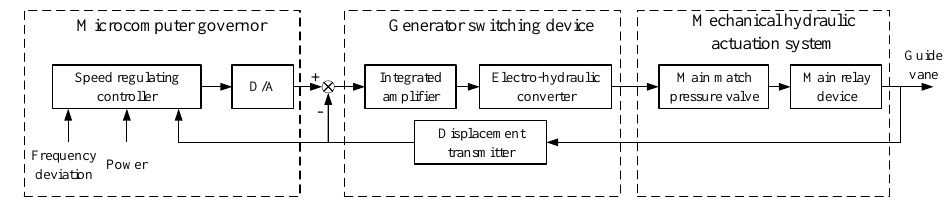
Figure 6. The basic structure of the PSU governor.